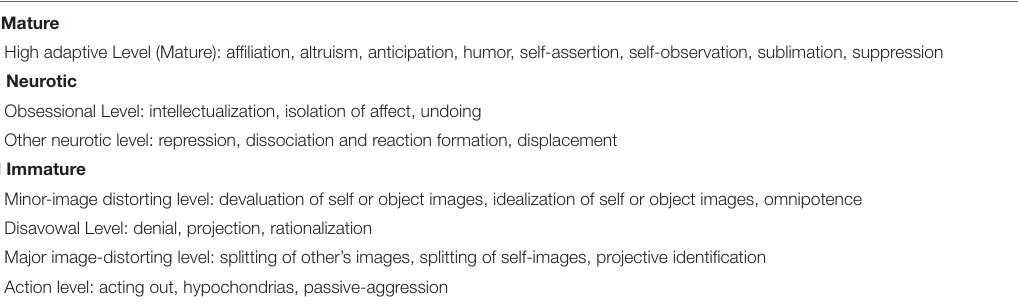
TABLE 1 | DMRS Hierarchy of defense categories, levels, and individual defense mechanisms adapted from Perry et al.